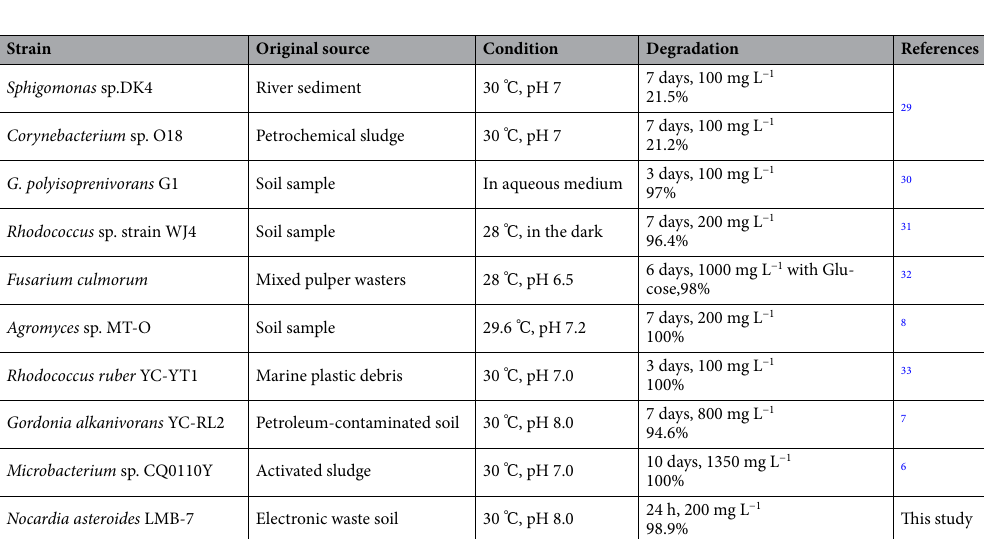
Table 2. Comparison of LMB-7 with other reported species regarding their ability to degrade DEHP.